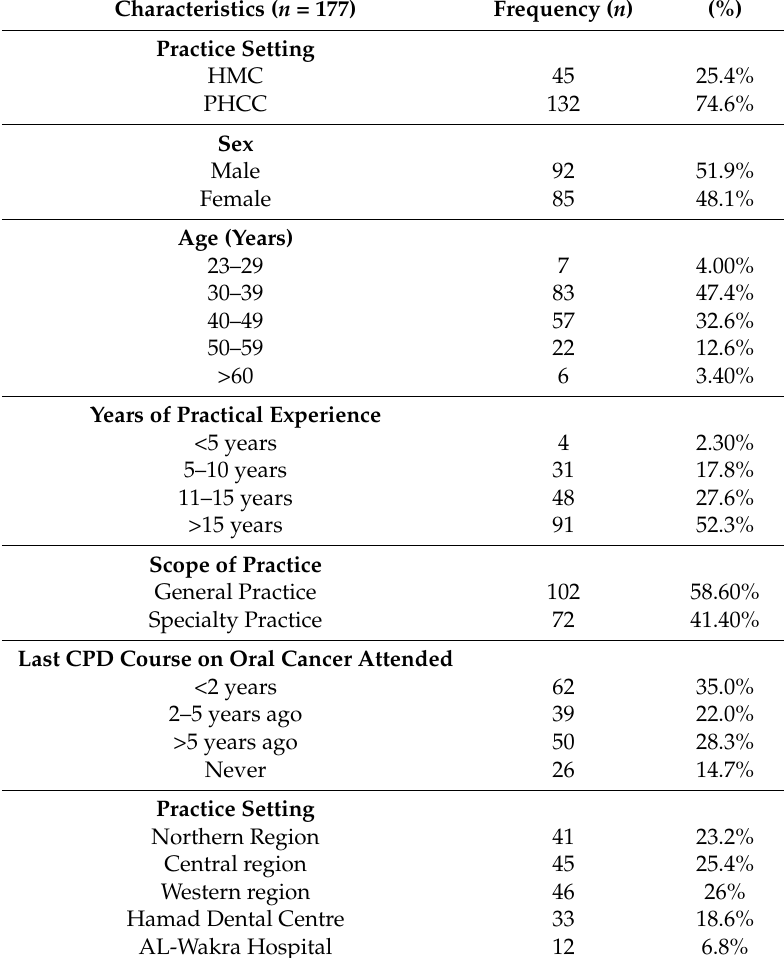
Table 1. Personal characteristics of the participants.